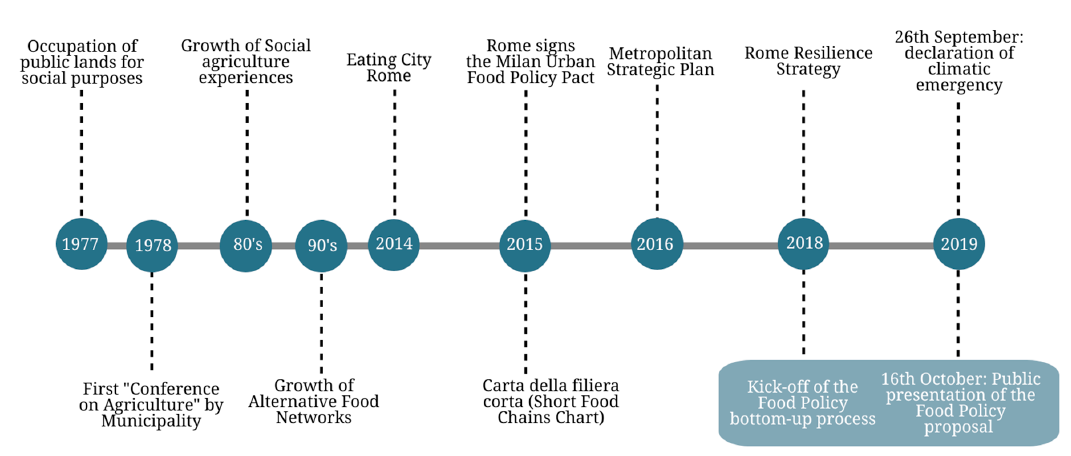
Figure 3. Milestones towards a Food Policy for Rome. Source: our elaborations.